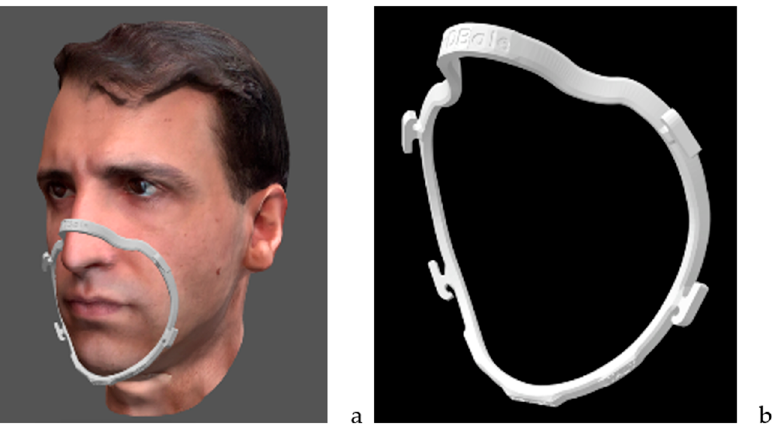
Figure 2. ( a , b ): The Mask Fitter design generated by the software.